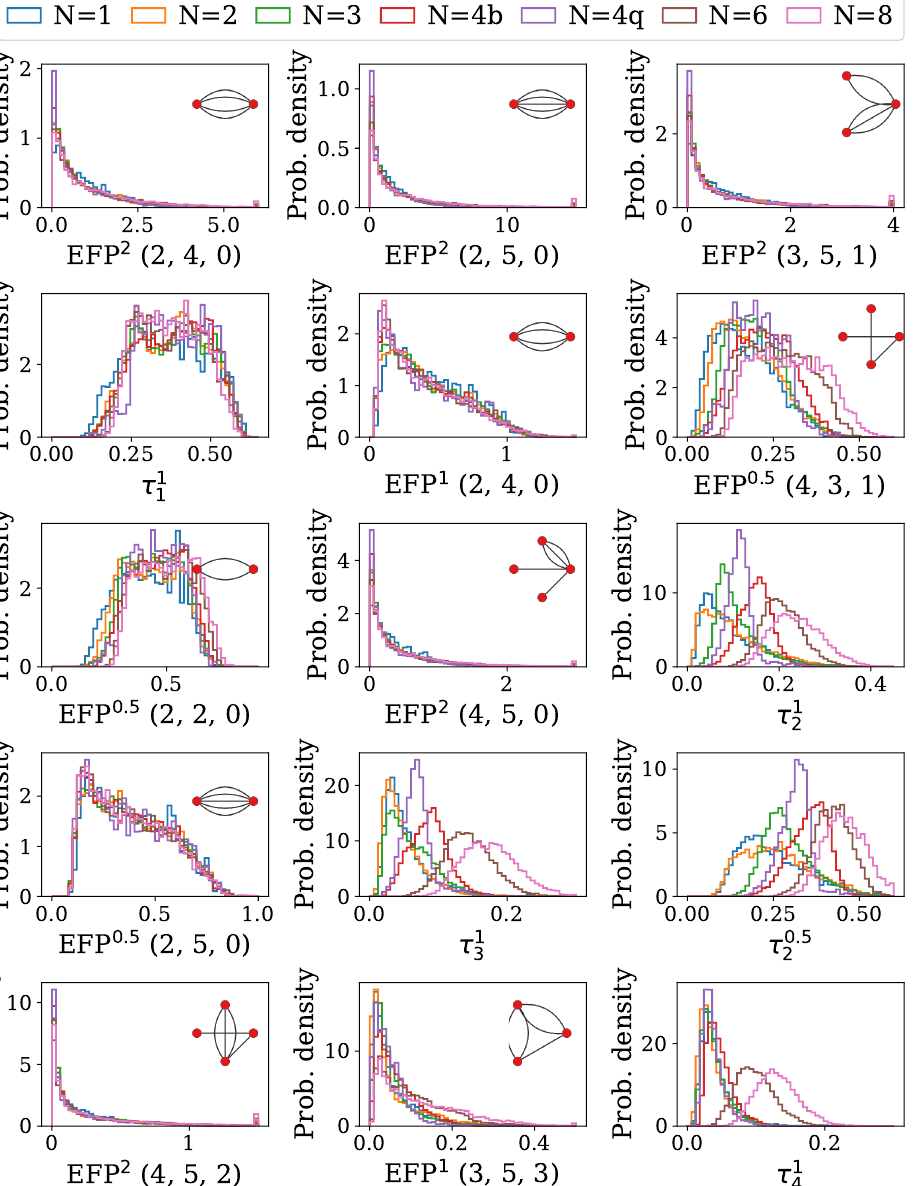
Figure 11 . Distributions of the first half of the most important LASSO-selected observables. The plots are ranked left-to-right top-to-bottom in order of importance according to the method described in section 6.3. For each EFP observable, the corresponding graph is also displayed for visualization purposes. The jet mass, which ranks between τ 1 variable, is omitted for brevity as this distribution is approximately flat by design, and is already shown in figure 2. The distributions of the rest of the LASSO-selected observables are shown in figure